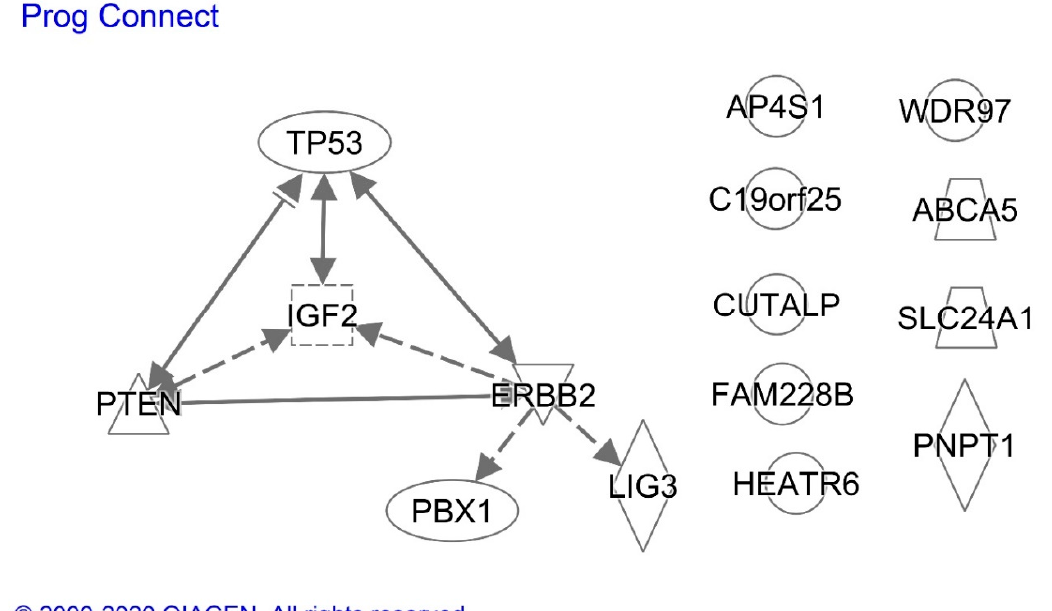
Figure 3. Ingenuity analysis of prognostically significant proteins with altered expression in endometrioid endometrial cancer specimens from Black compared with White patients. Solid and dotted lines indicate the direct and indirect effects, respectively, of the indicated protein on the protein to which the arrowhead is pointing. ERBB2 = HER2/NEU. Proteins without arrows had no evidence of a connection with the other proteins in the current scientific literature.